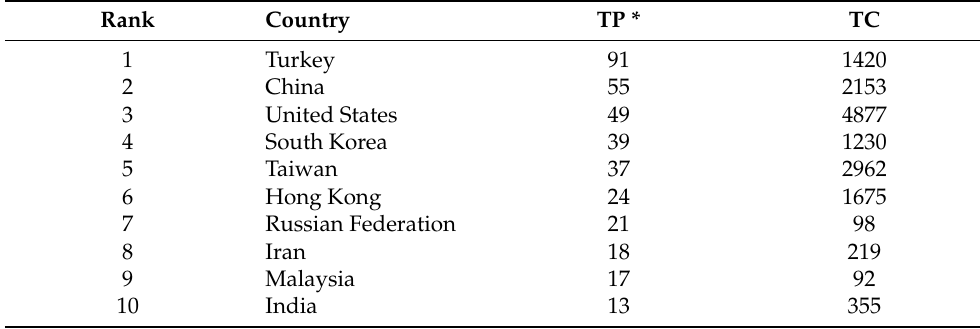
Table 5. Top 10 countries with most publications in digital